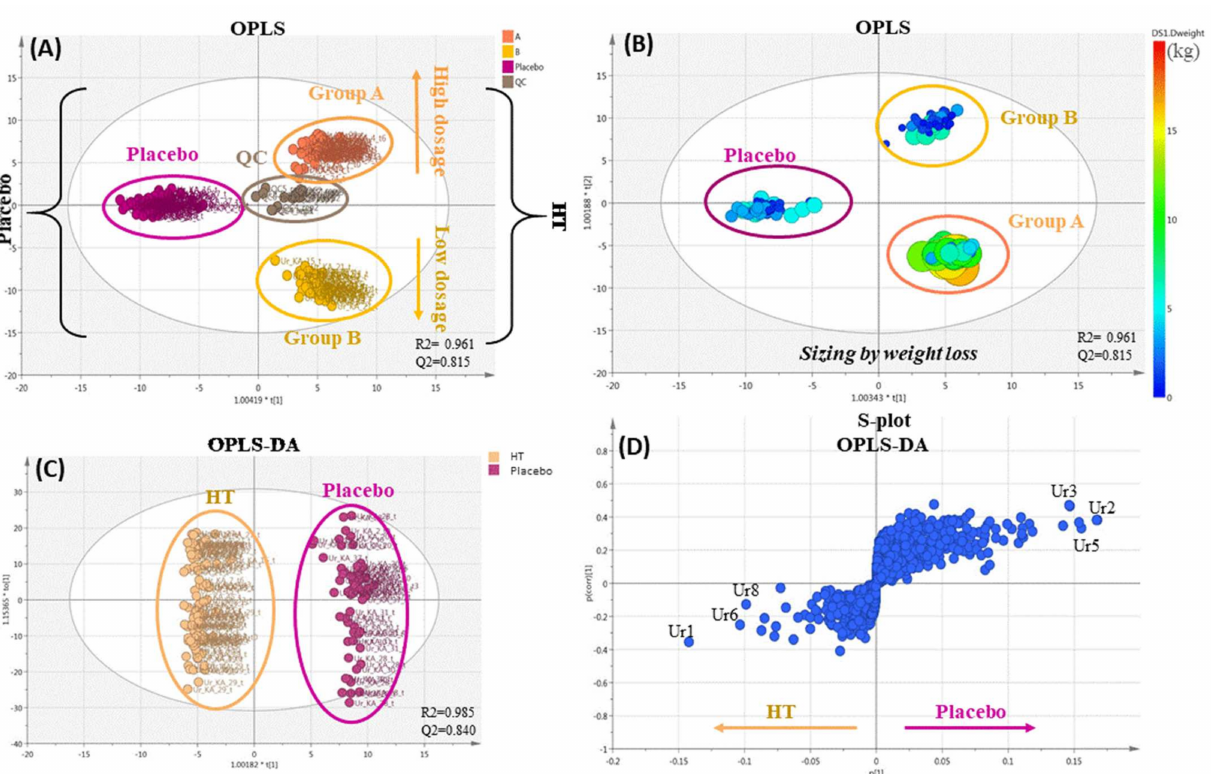
Figure 3. Scores and loading plots of urine samples. ( A ) Orthogonal partial least squares (OPLS) scores plot with observations colored according to the treatment group and dosage (unit variance (UV) scaling). ( B ) OPLS scores plot with observations sized and colored according to weight loss. The colored bar ranges from blue—low values to red—high values; it illustrates the weight loss in kg (UV scaling). ( C ) Orthogonal partial least squares–discriminant analysis (OPLS-DA) of the hydroxytyrosol (HT) and placebo groups (UV scaling). ( D ) S-plot of the OPLS-DA scores plot (UV scaling). The R2/Q2 model parameters are annotated